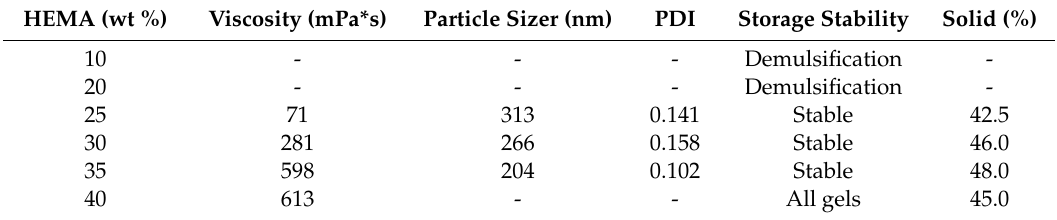
Table 1. E ff ect of HEMA dosage on the properties of